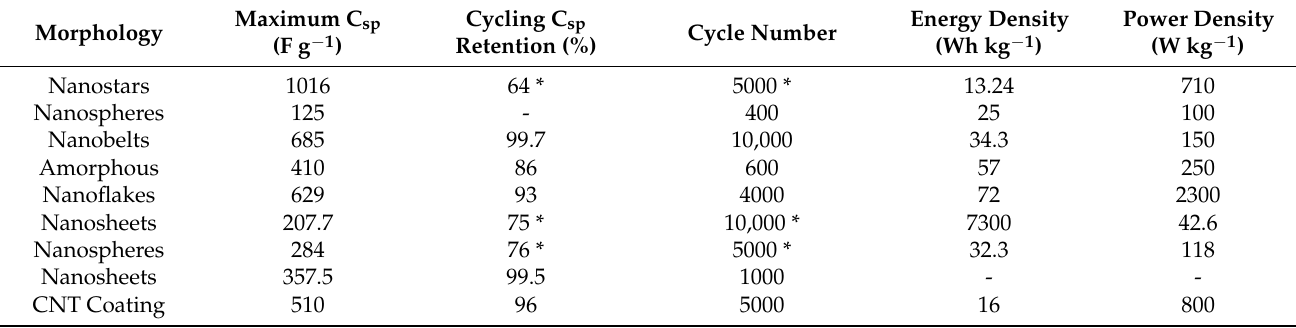
Table 2. V 2 O 5 morphology and electrochemical performances of V 2 O 5 /carbon nanotube composite electrodes for superca- pacitor